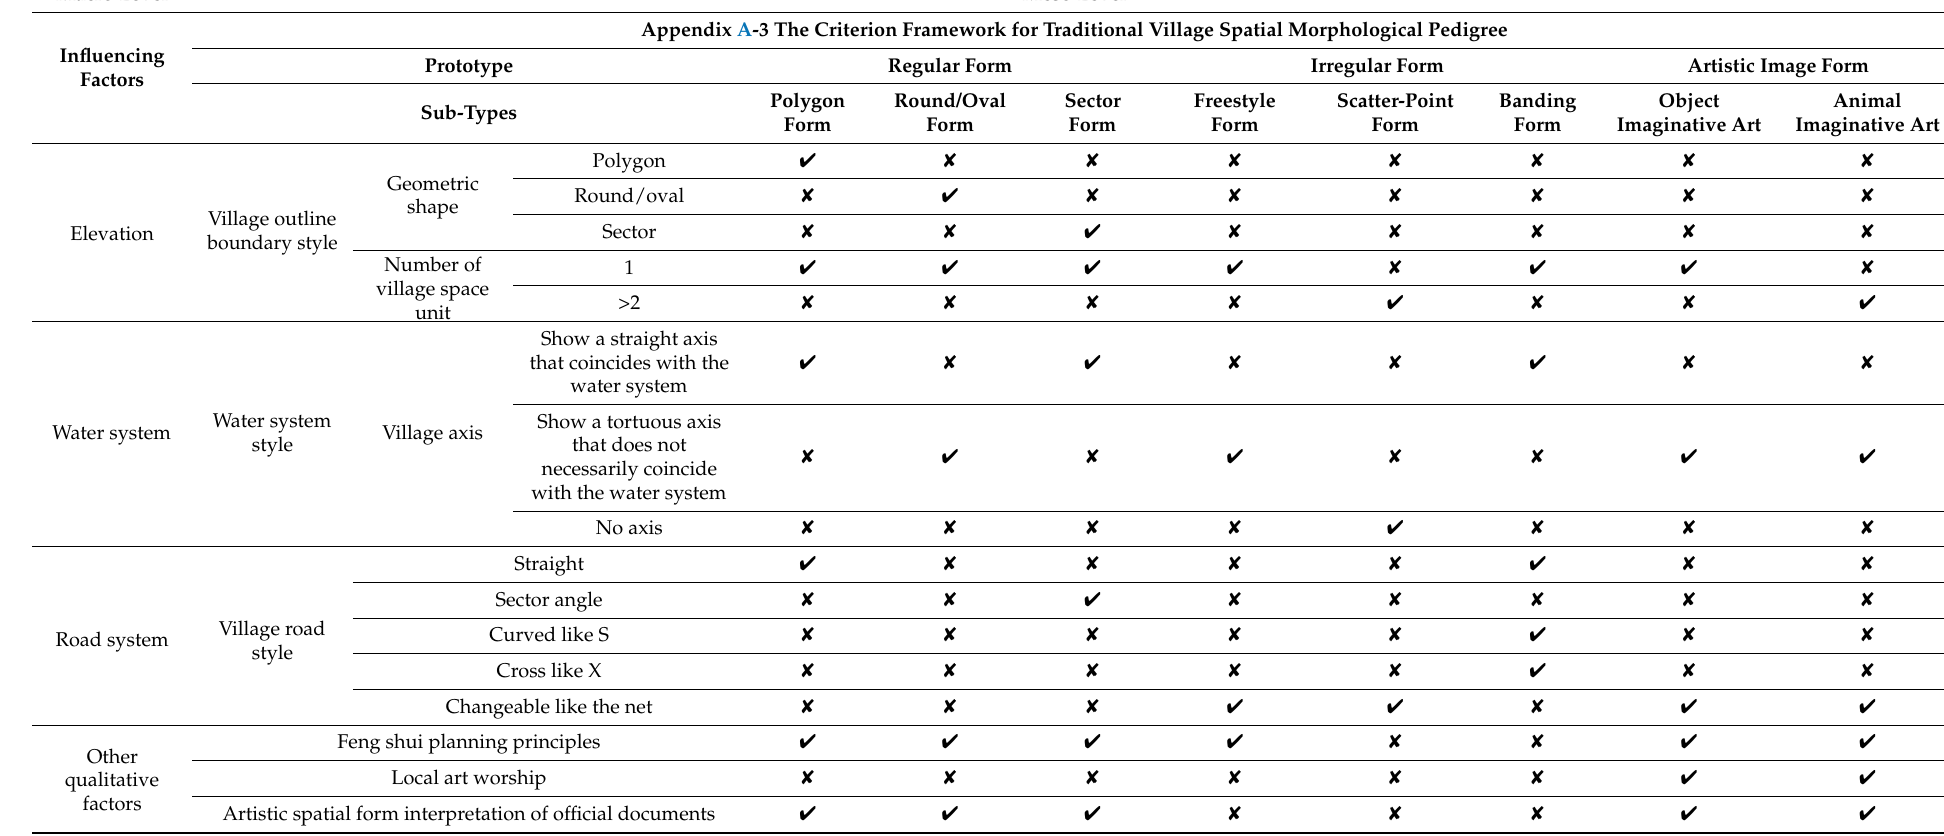
Table A4. The Criterion Framework for Traditional Village Spatial Morphological Pedigree: Edited by